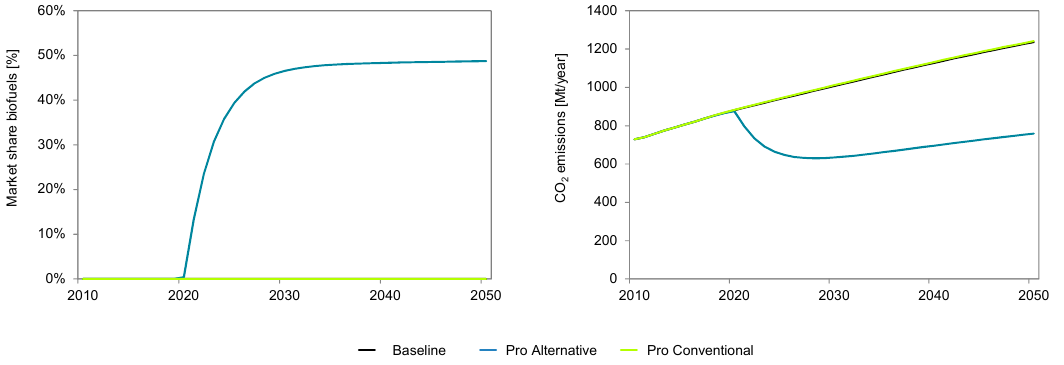
Figure 5. Market shares and CO 2 emissions for biofuels for the baseline (black), pro alternative (blue), and pro conventional (green) scenario.